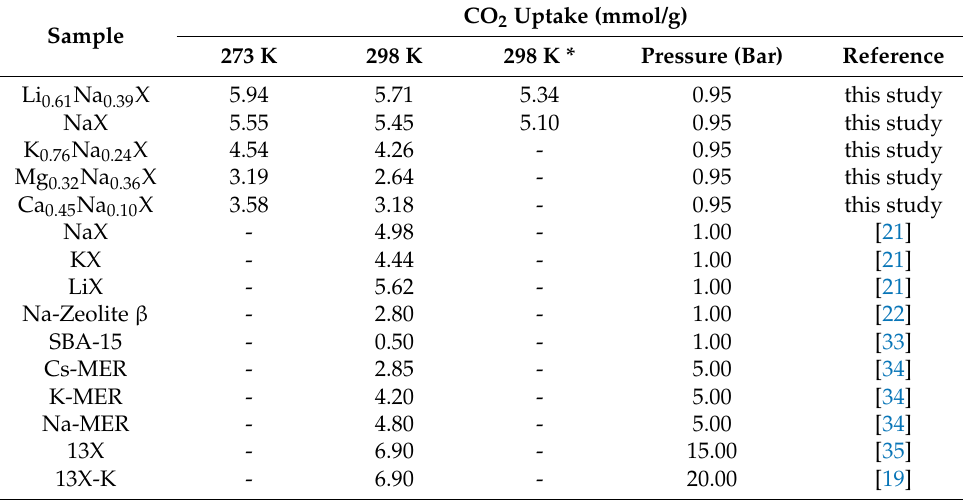
Table 5. CO 2 uptake capacities of the studied